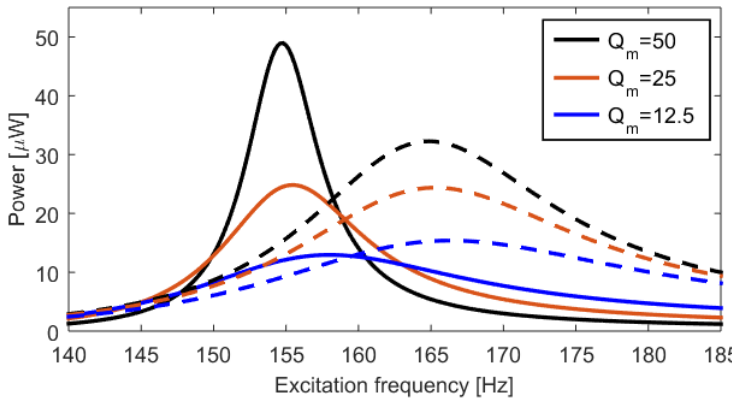
Figure 9. Power output at different quality factors at the corresponding R op_res (solid curves) and at R d (dashed curves).